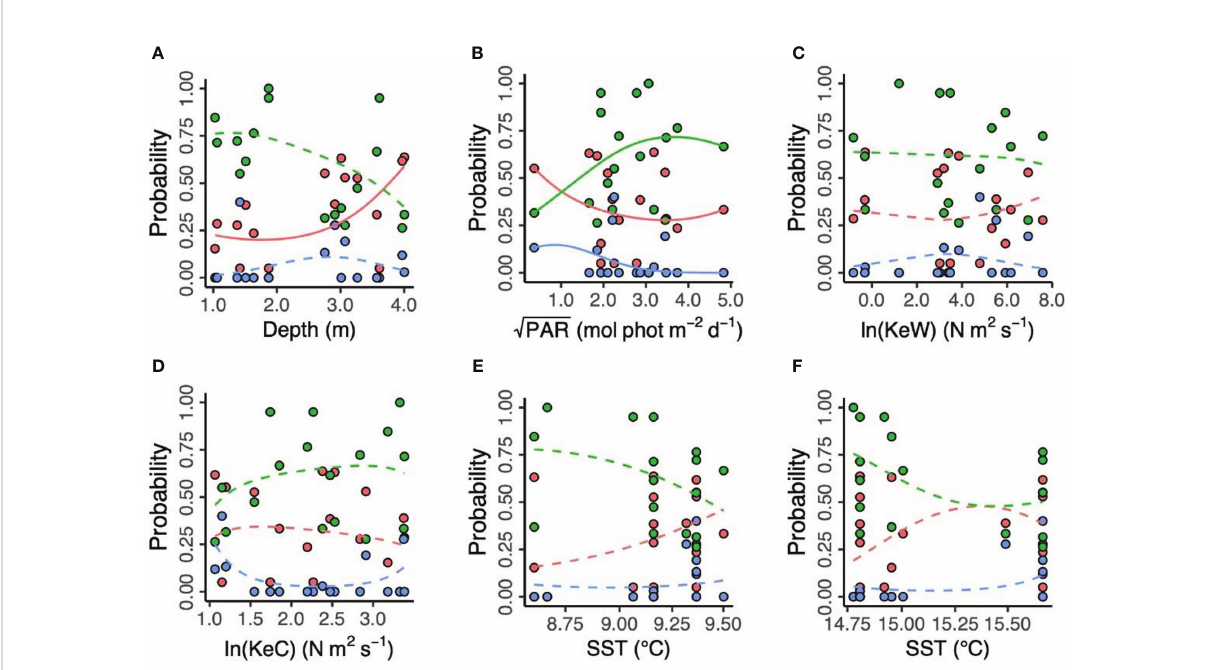
FIGURE 4 Environmental predictors of three putative Zostera marina clusters ( “ red, ” “ green, ” and “ blue ” ) in 17 locations across the south coast of England. (A) Depth is below chart datum. (B) PAR is photosynthetically active radiation at the seabed. KeW (C) and KeC (D) are kinetic energy, associated with waves and currents, respectively. SST is sea surface temperature in March (E) and August (F) 2016. Solid lines show statistically signi fi cant relationships ( p < 0.05), with non-signi fi cant relationships shown as dashed lines.